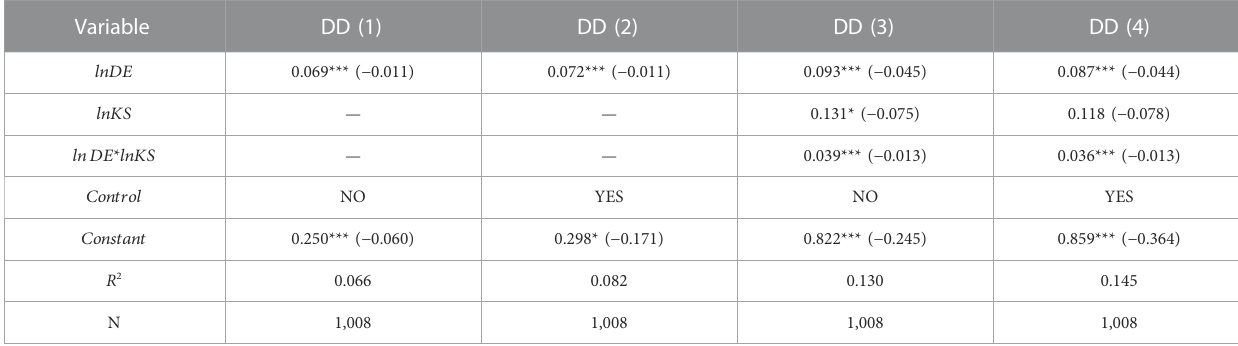
TABLE 10 Robustness tests for the fi xed-effect model.